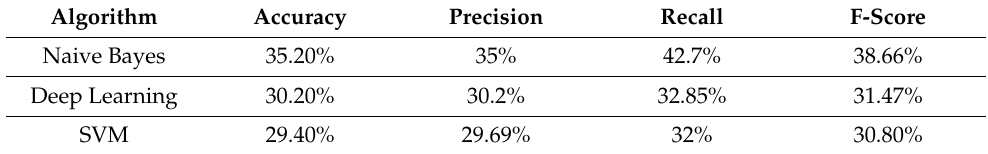
Table 6. The results of validation of the estimated damage map from Naive Bayes, SVM, and deep learning at the 10 × 10 km raster grids scale with accuracy, precision, recall, and F-score